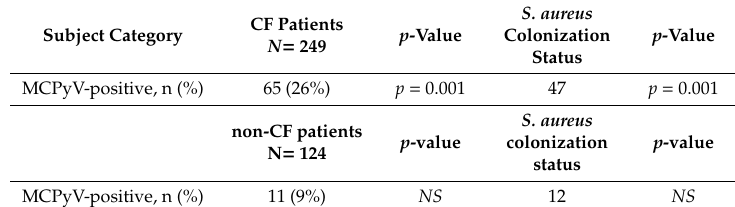
Table 3. AssociationofCFdiseasewithMCPyVDNApresenceand Staphylococcusaureus